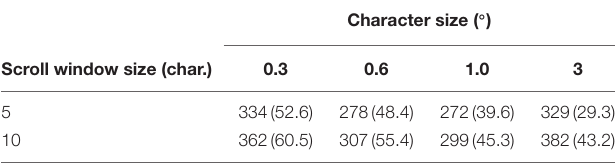
TABLE 1 | Average threshold exposure durations in Experiment 1(ms).